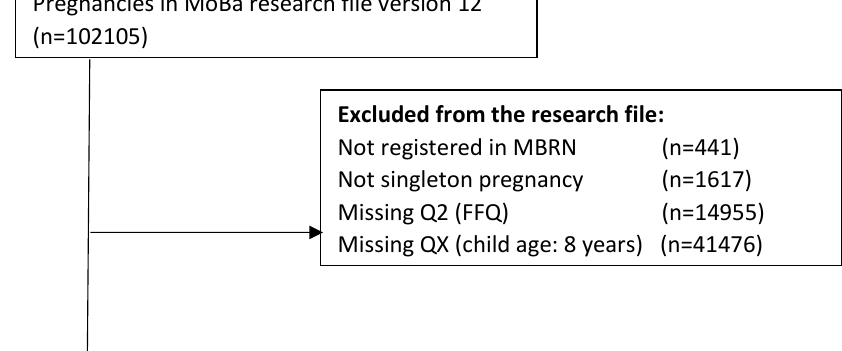
Figure 1. Flow chart inclusion of participants in the study